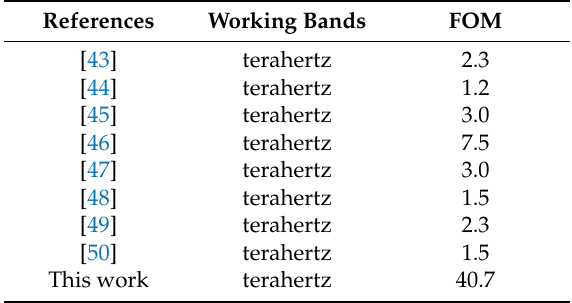
Table 1. Comparison of FOM (figure of merit) values among terahertz